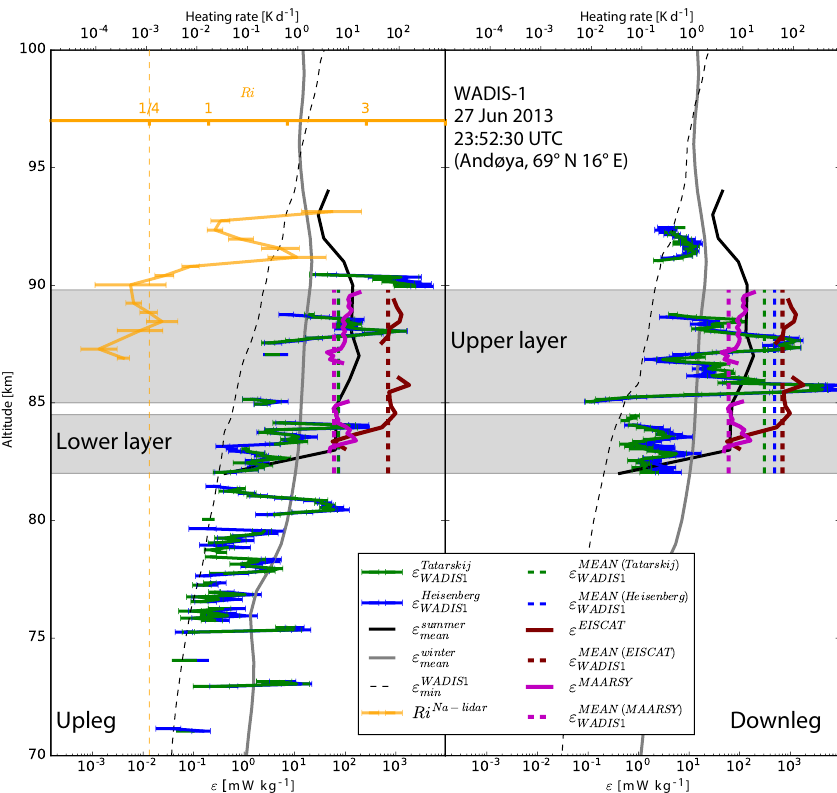
/homenas/home/oa002/workspace/WADIS/wadisXXXplt.py run on 2017-03-20 16:53:30.696745; data files: wadis1c4e4fwdup_guifit2_filt2.npz; wadis1c6e3aftdown_guifit2_filt2.npz; Wadis1HorwindZe5_6T.mat; Wadis1_Eiscat_Wms_T.mat; Na_lidar_Richardson_number_new_2013_06_27_20min.txt Figure 12. Turbulence energy dissipation rates measurements during the WADIS-1 sounding rocket flight. The left and right panel show up- and downleg data, respectively. Blue and green lines show the ε values derived from the CONE measurements using Heisenberg (1948) and Tatarskii (1971) spectral models. Magenta and dark red are for the vertical beam measurements with MAARSY and EISCAT VHF radar. The solid gray and black lines show ε climatologies for winter (Lübken, 1997) and summer (Lübken et al., 2002). The vertical colored dashed lines show vertical means between 80 and 90km, (cid:104) ε (cid:105) . The colors are the same as for instant values. Black dashed line shows ε min = ν × ω 2